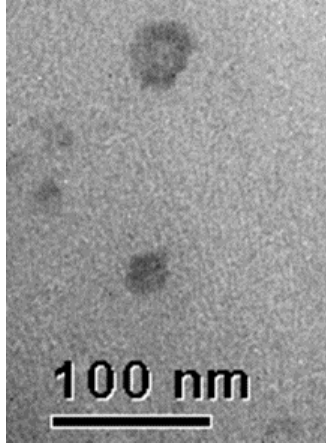
Figure 3. TEM image of IDE loaded SLN.